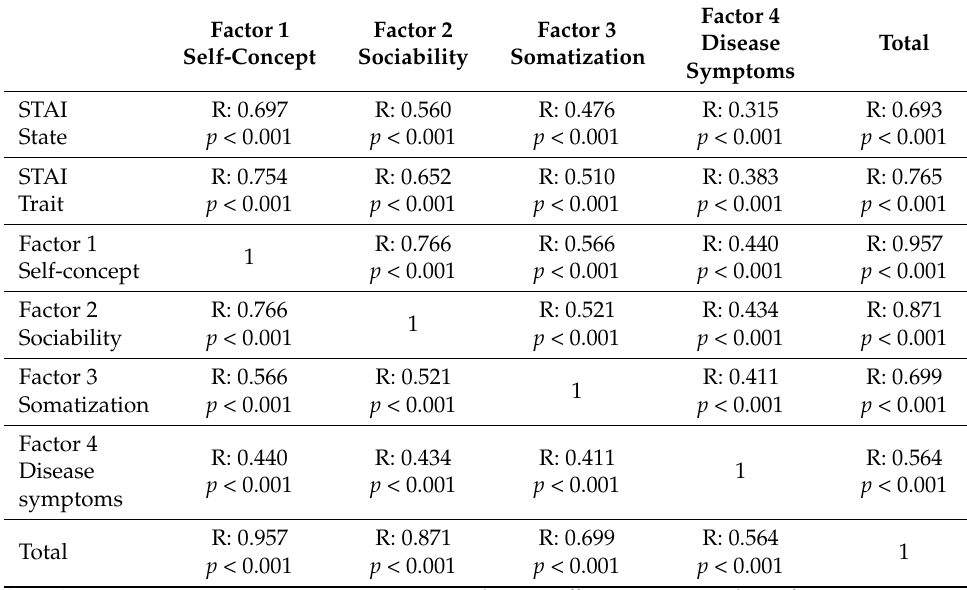
Table 3. Analysis of the validity of the questionnaire’s criteria and the correlation between factors and the total scale.